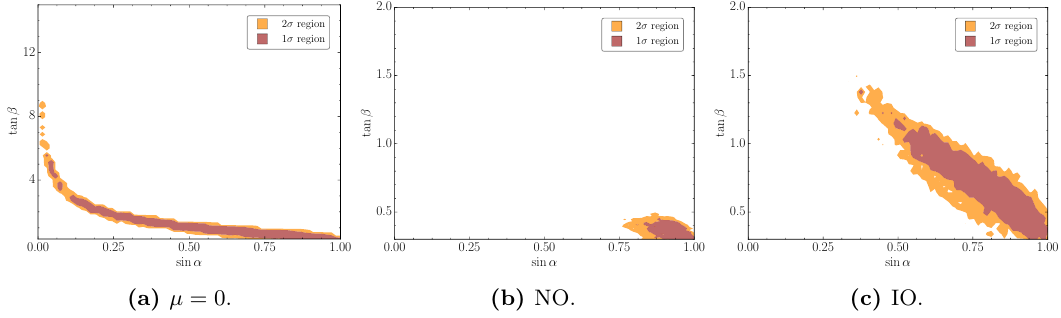
Figure 10. Allowed regions of the mass m H and the branching ratio Br( h (b) NO, and (c) IO.